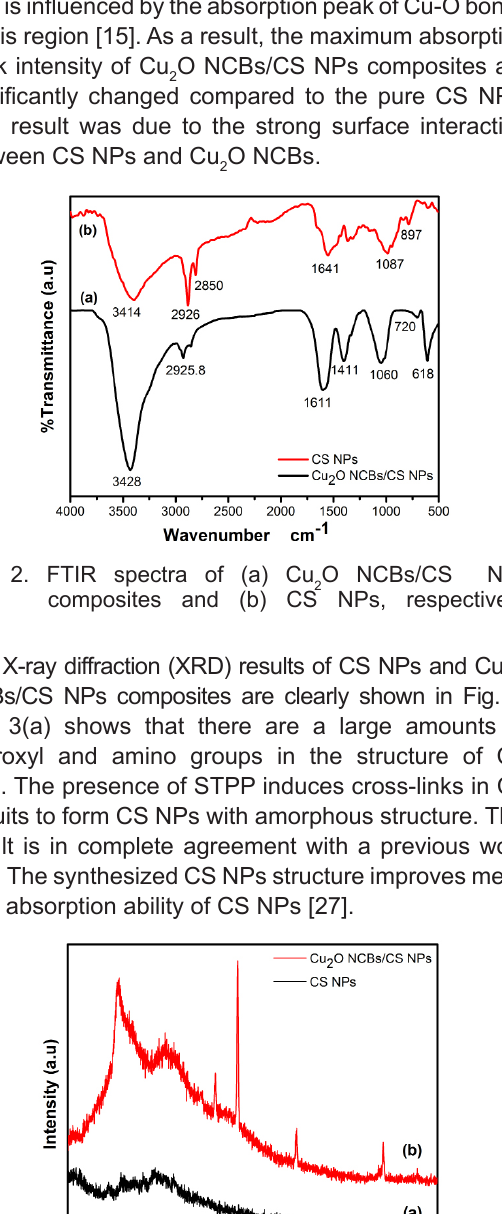
Fig. 3. X-ray diffraction (XRD) patterns of (a) CS NPs and (b) Cu O NCBs/CS NPs composites, respectively. 2